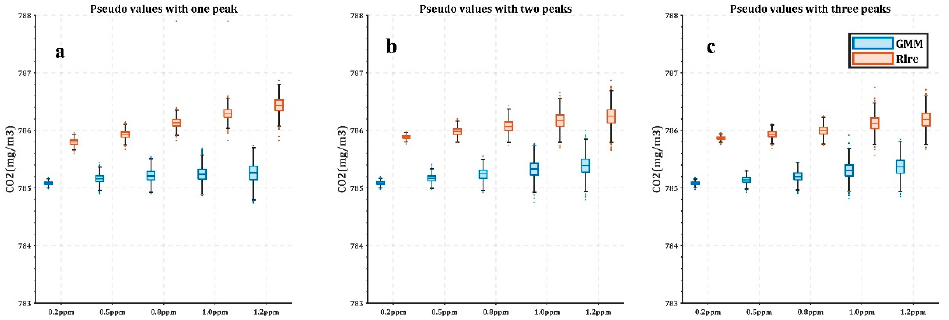
Figure 4. Estimated results of CO 2 background concentration under different pseudo measure-